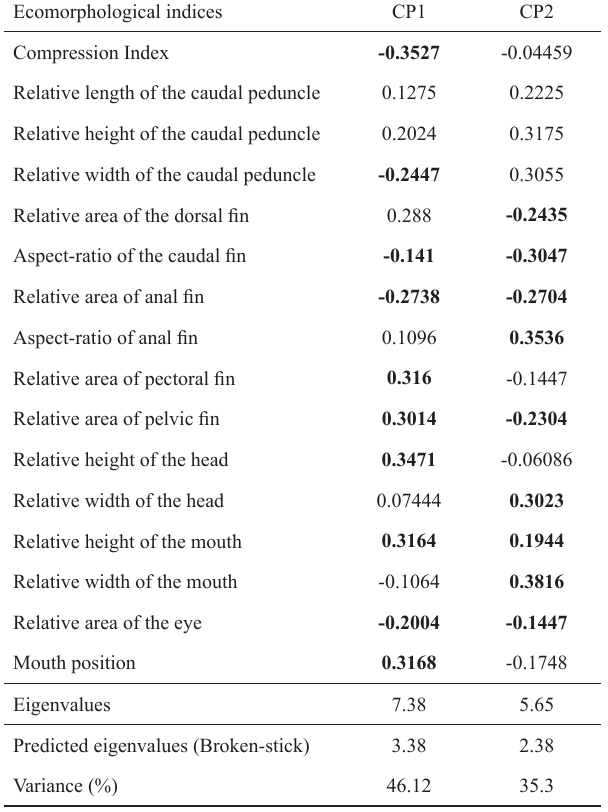
Table 3. Eigenvectors, eigenvalues and percentage of explicability of the first two axes (PCA 1 and PCA 2) from the principal components analysis (PCA) applied to the correlation matrix of 15 ecomorphological indices and mouth orientation for the fish assemblage in Jumelo stream, Iguaçu National Park, Paraná, Brazil. Values in bold indicate the five respective eigenvectors that more contributed negatively, and the five eigenvectors that more contributed positively to the formation of PCA 1 and PCA 2.